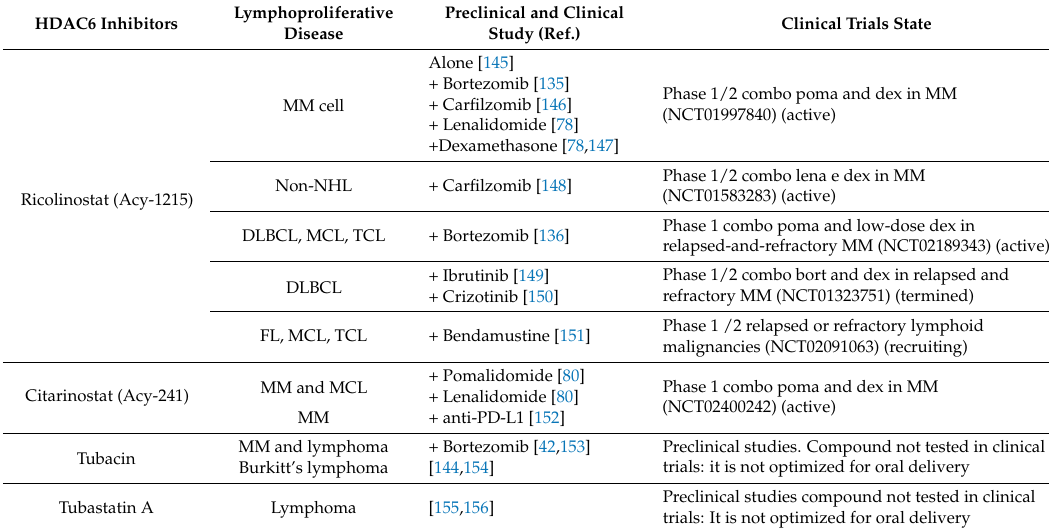
Table 4. HDAC6 inhibitors in lymphoproliferative